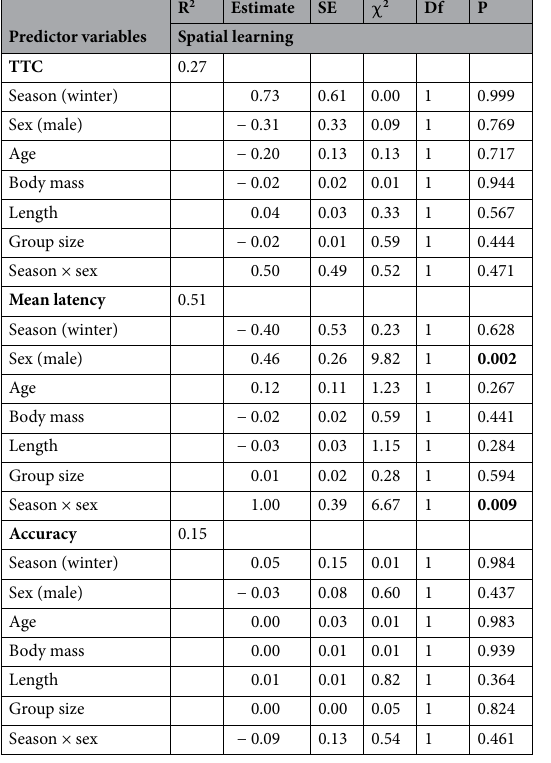
Table 2. Results from LMM and GLMM analyses for the influence season, sex, age, body mass, length and group size on the learning performance, group ID is a random factor (bold values P <